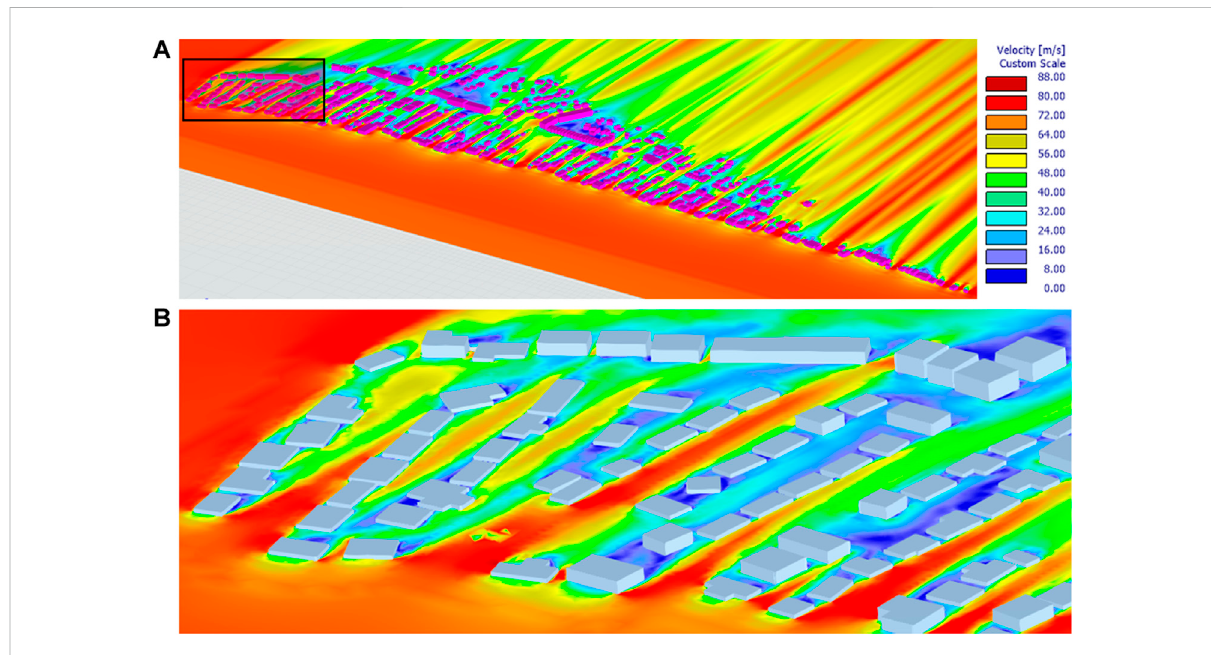
FIGURE 11 Themodeledwind fl owforthestudyarea (A) Thespatialdistributionofwindspeedacrossthecommunity; (B) Close-upviewonthewindspeed